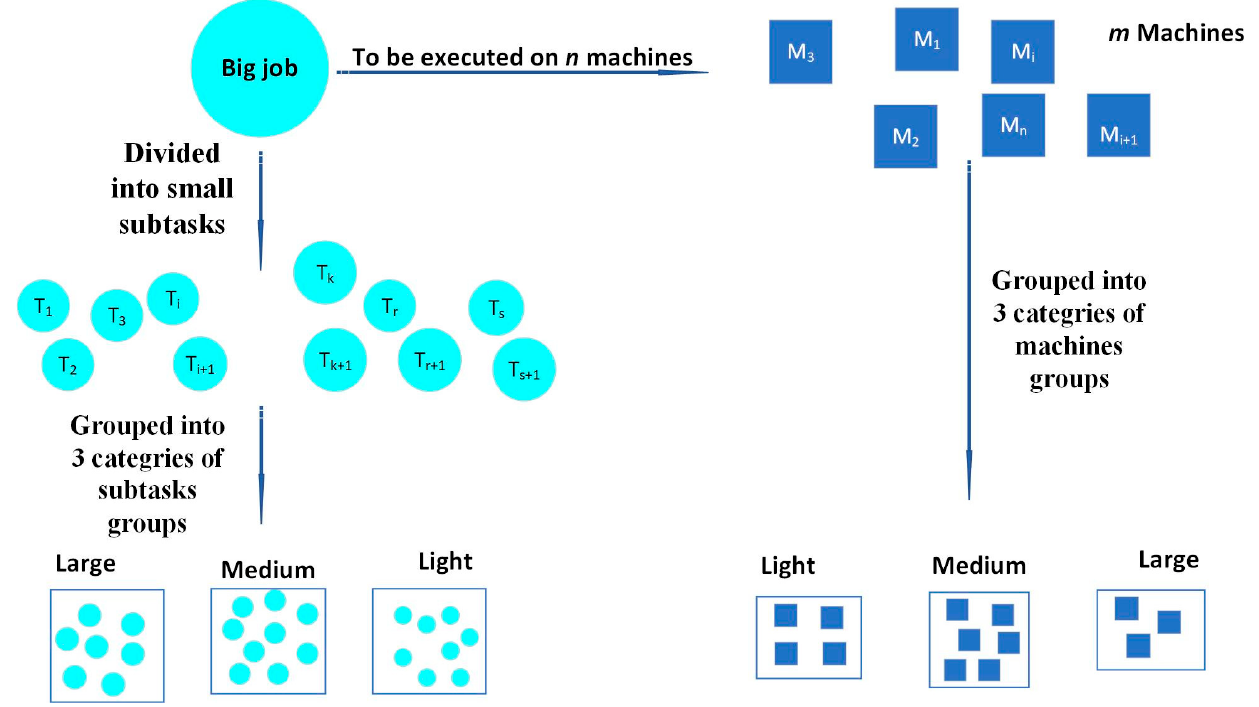
Figure 1. Grouping of devices with tasks based on the device’s capabilities.